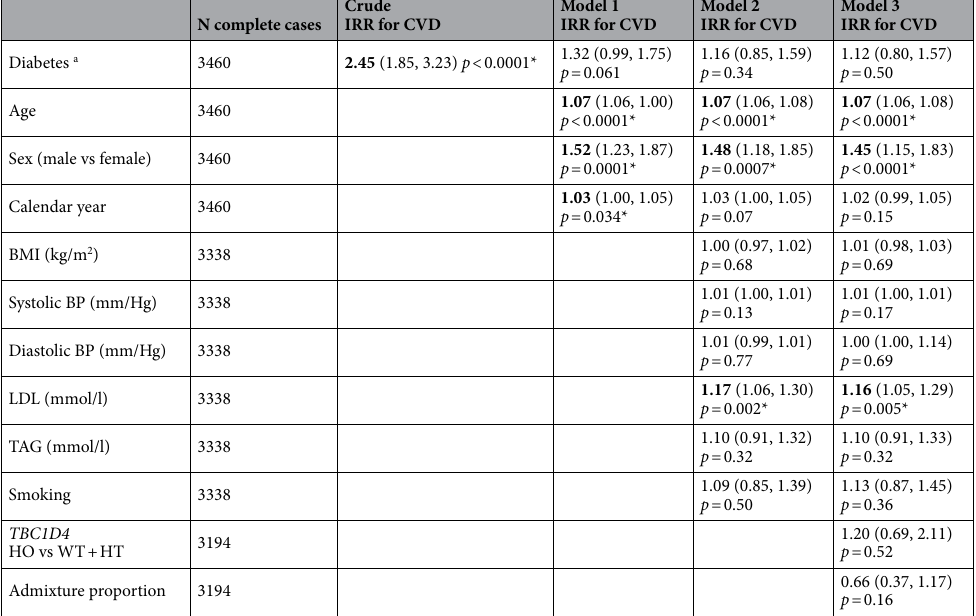
Table 4. The effect of diabetes and a recessive model of the TBC1D4 variant on CVD risk. Poisson regression with incidence rate ratios (IRR) and (confidence limits). *Effect sizes in bold below 5% significance level. a Diabetes is both screen-detected and self-reported. Model 1: adjusted for age, sex and calendar year; Model 2: model 1 + BMI, systolic BP, diastolic BP, LDL cholesterol, TAG and smoking; Model 3: model 2 + TBC1D4 and